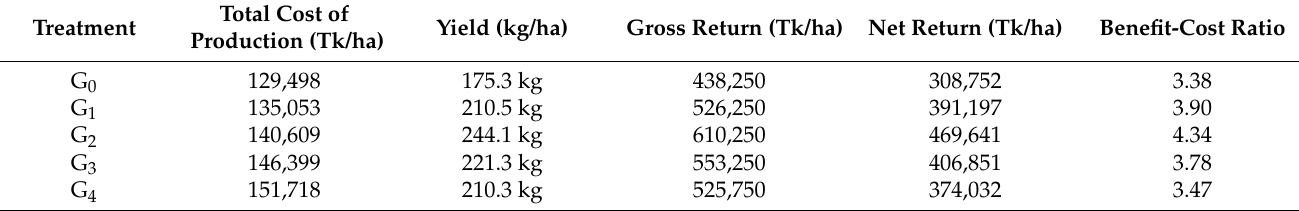
Table 7. Economic analysis of BU cauliflower-1 seed production as influenced by different times of application and GA 3